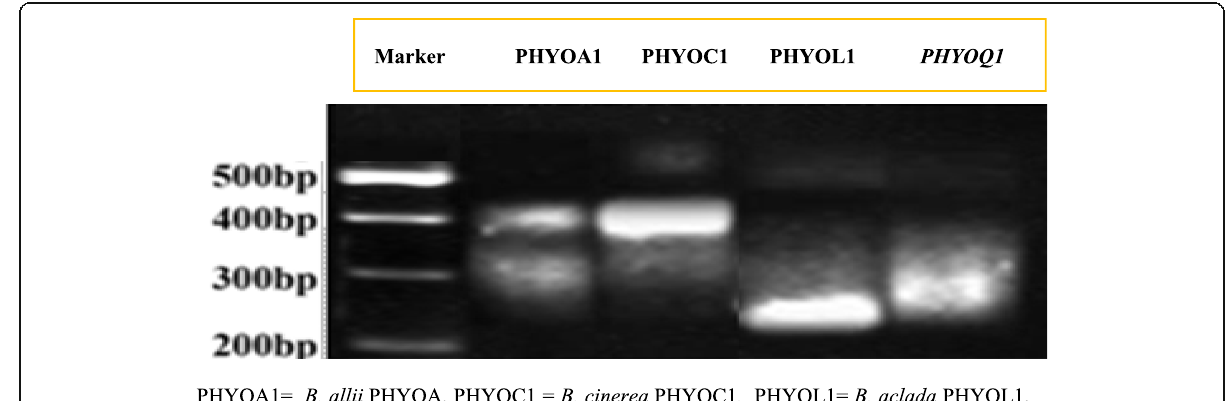
Fig. 1 PCR-RFLP analysis of four Botrytis spp. isolated from onion infected